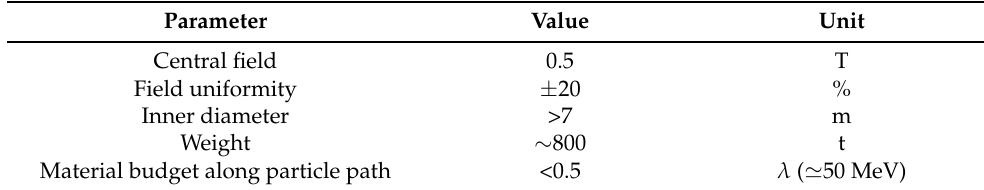
Table 12. Requirements and characteristics of the ND-GAr reference magnet design.